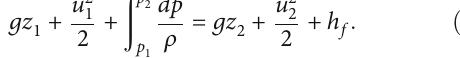
Figure 1. The introduction of the mathematical model